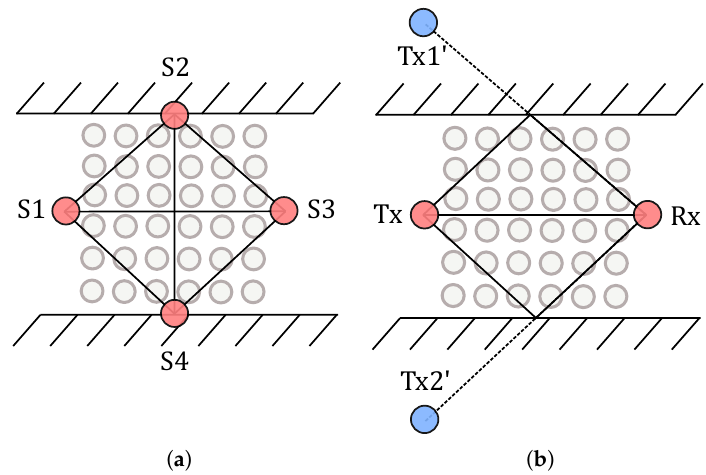
Figure 1. Comparison of DFL systems c (cid:13) 2020 IEEE, Reprinted, with permission, from [5]. ( a ) Conventional DFL. ( b ) Multipath-assisted